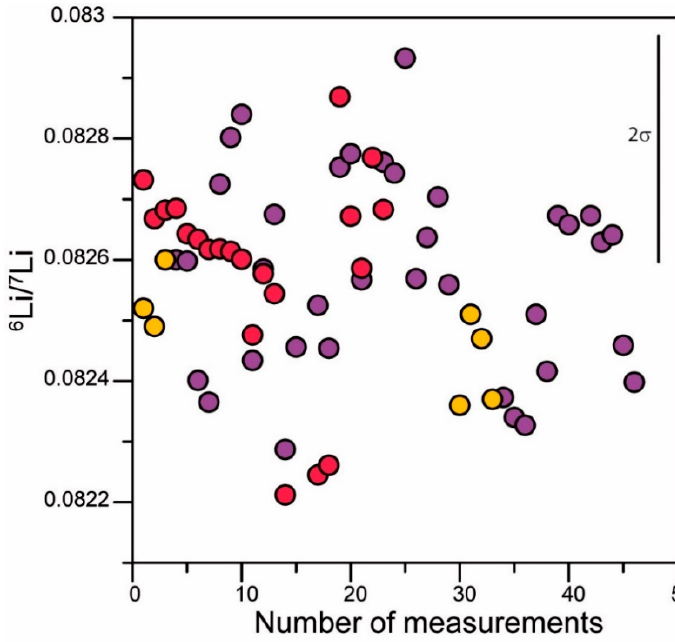
Figure 8. Results of NIST L-SVEC lithium standard measurements at the INGV, OV (purple circles) and DiSTAR (red circles). Orange circles are relative to standards passed through the columns, then collected and loaded on Re filaments.